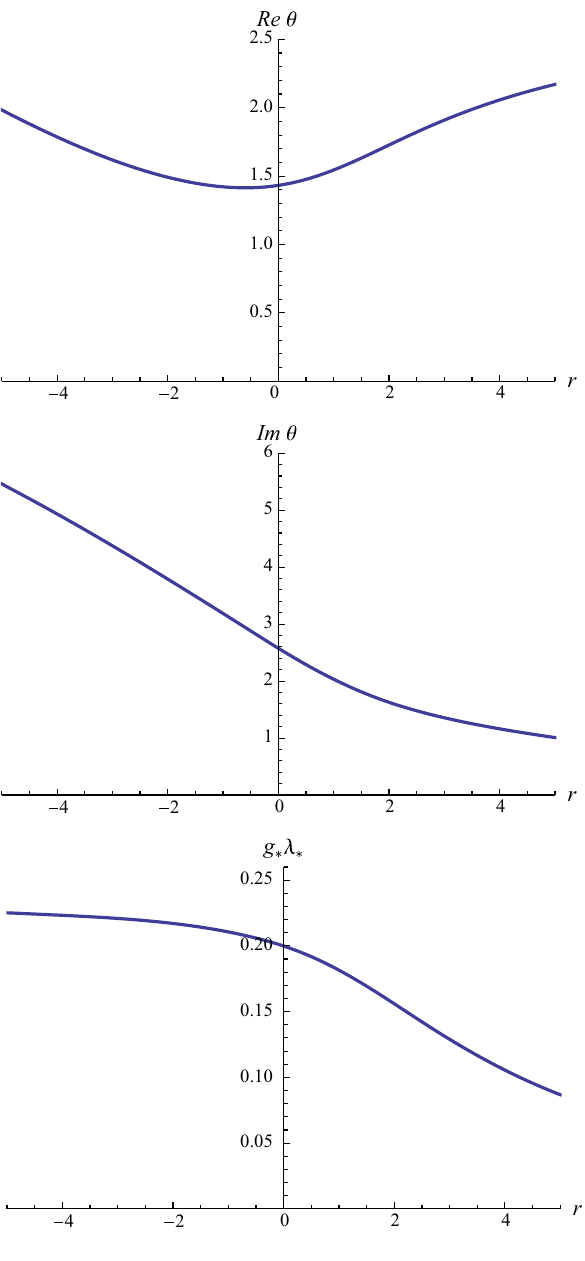
Fig. 2 Illustration of the r -dependence of the stability coefficients and universal product g ∗ λ ∗ of the NGFP found for the linear split ( α = 0). The real part of θ possesses a minimum for r linear opt = − 0 . 605 while Im θ and g ∗ λ ∗ decrease monotonically for increasing r